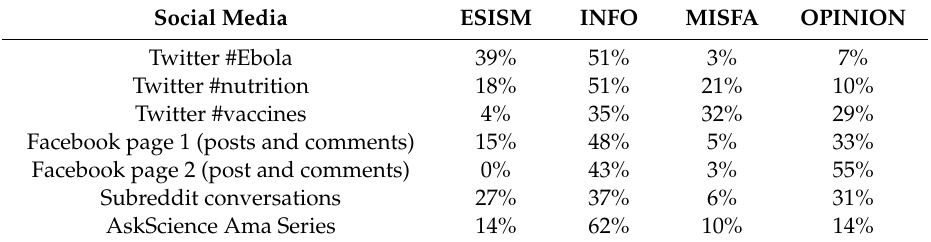
Table 4. Percentage of coded messages in relation to data collected by each social media channel selected.